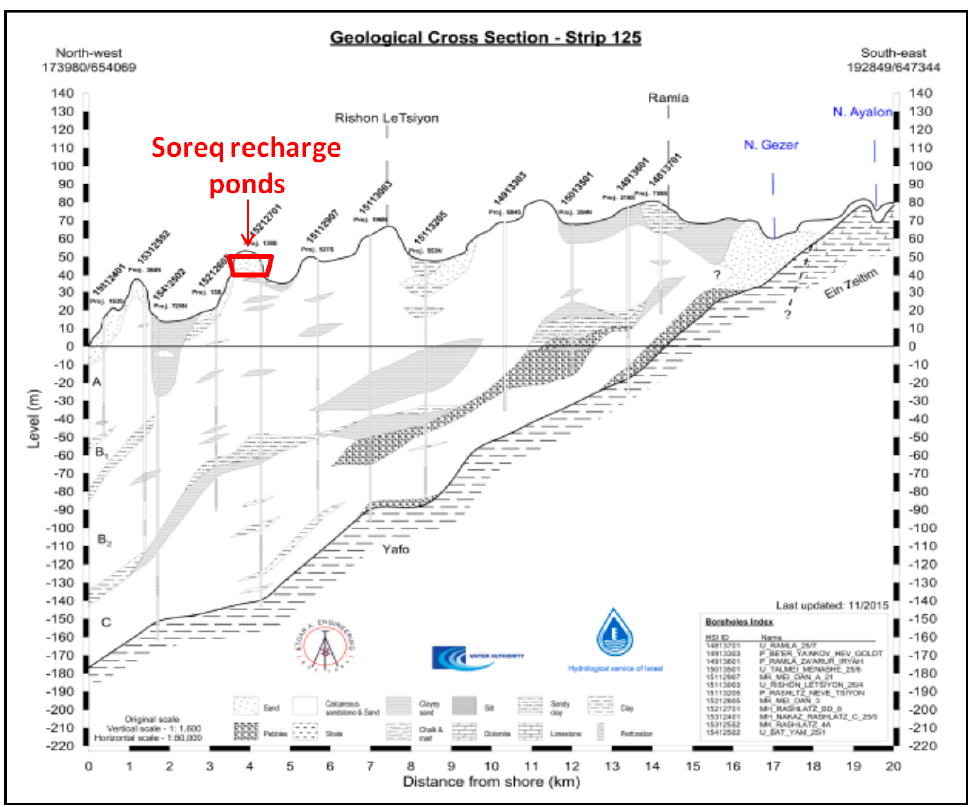
Figure 1. Cross section of the Coastal Aquifer and the area of the Soreq recharge basin (after [24]).